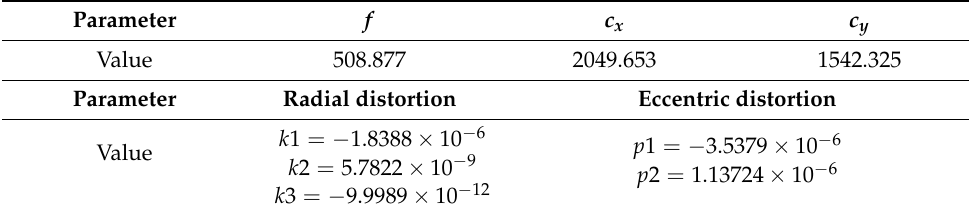
Table 4. Intrinsic parameters of the camera.